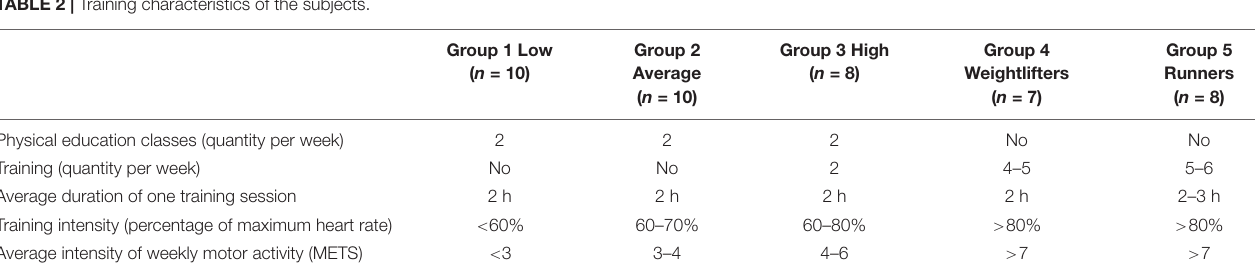
TABLE 2 | Training characteristics of the